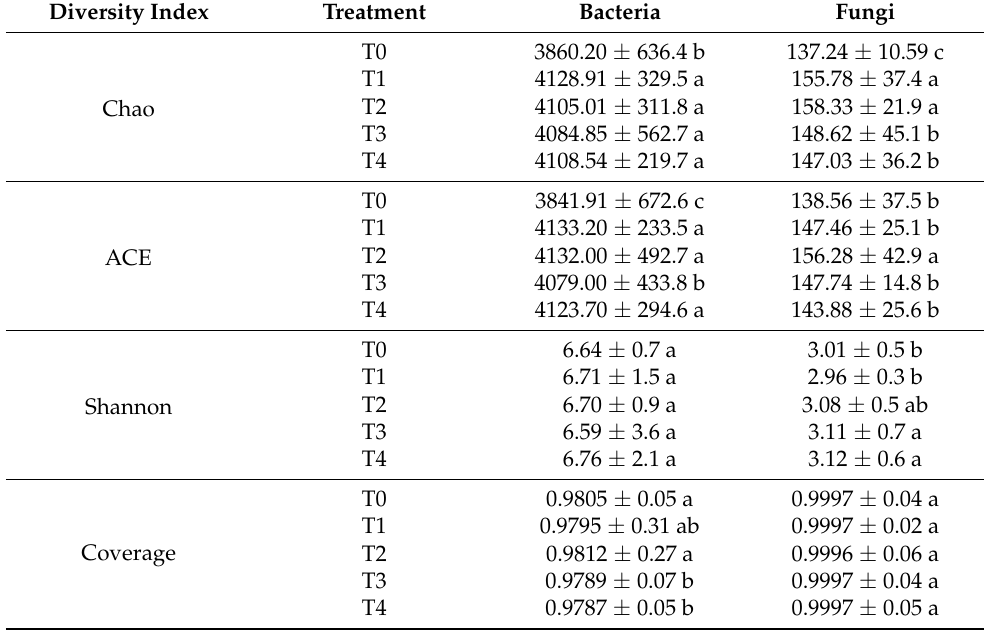
Table 3. Analysis of diversity indices among different treatments. The data are means ± standard deviation. Different lowercase letters in the same row indicate significant differences between treat- ments ( p < 0.05).